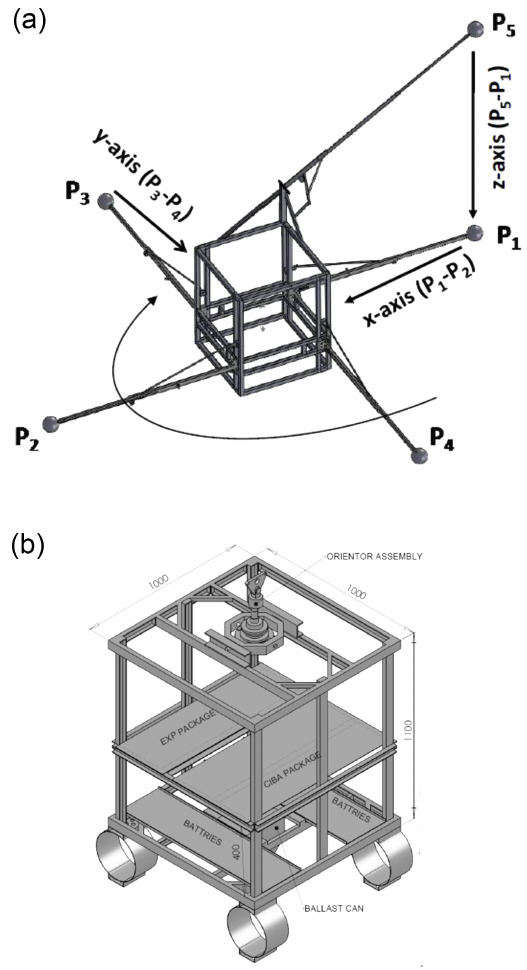
Figure 1. (a) A sketch of gondola (central body or the payload) and the booms shown in deployed condition (not to scale). The direc- tions of the three axes referenced with respect to the probe configu- ration are indicated. The curved line with an arrow at its tip indicates the direction of the rotation of gondola. The dimensions of the gon- dola are given in (b) . Details regarding the individual lengths of the booms are provided in the text. (b) A drawing of the gondola show- ing the locations of various subsystems (courtesy of the National Balloon Facility, TIFR, Hyderabad).